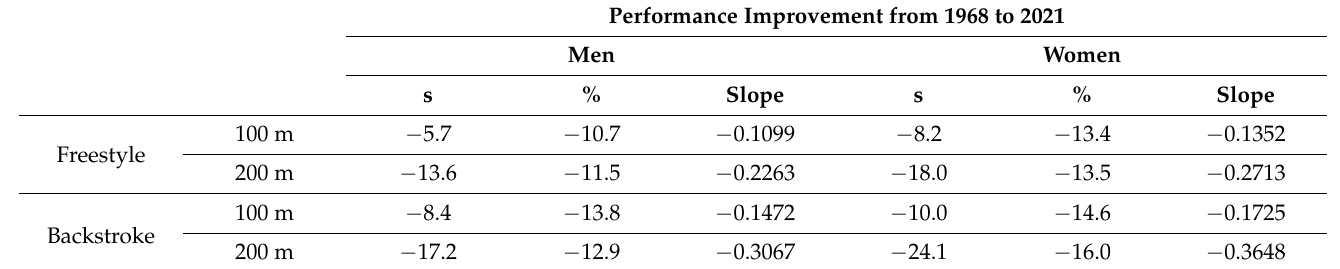
Table 4. Performance improvement in second (s), percentage (%) and slope of the regression line of results over time (slope) from 1968 to 2021 in Freestyle and Backstroke 100 m and 200 m for men and women.